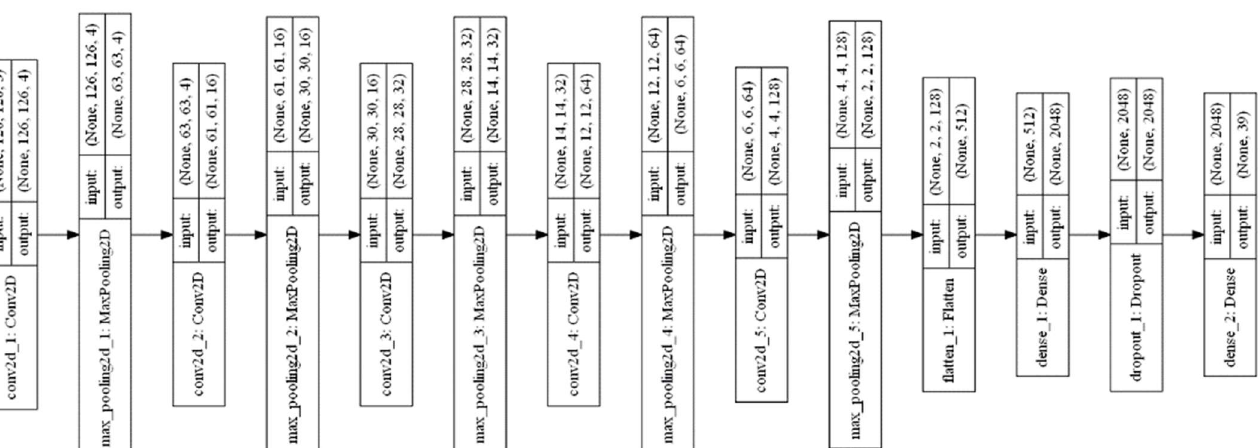
Table 4. Optimized hyperparameters of the conv-5 DCNN.